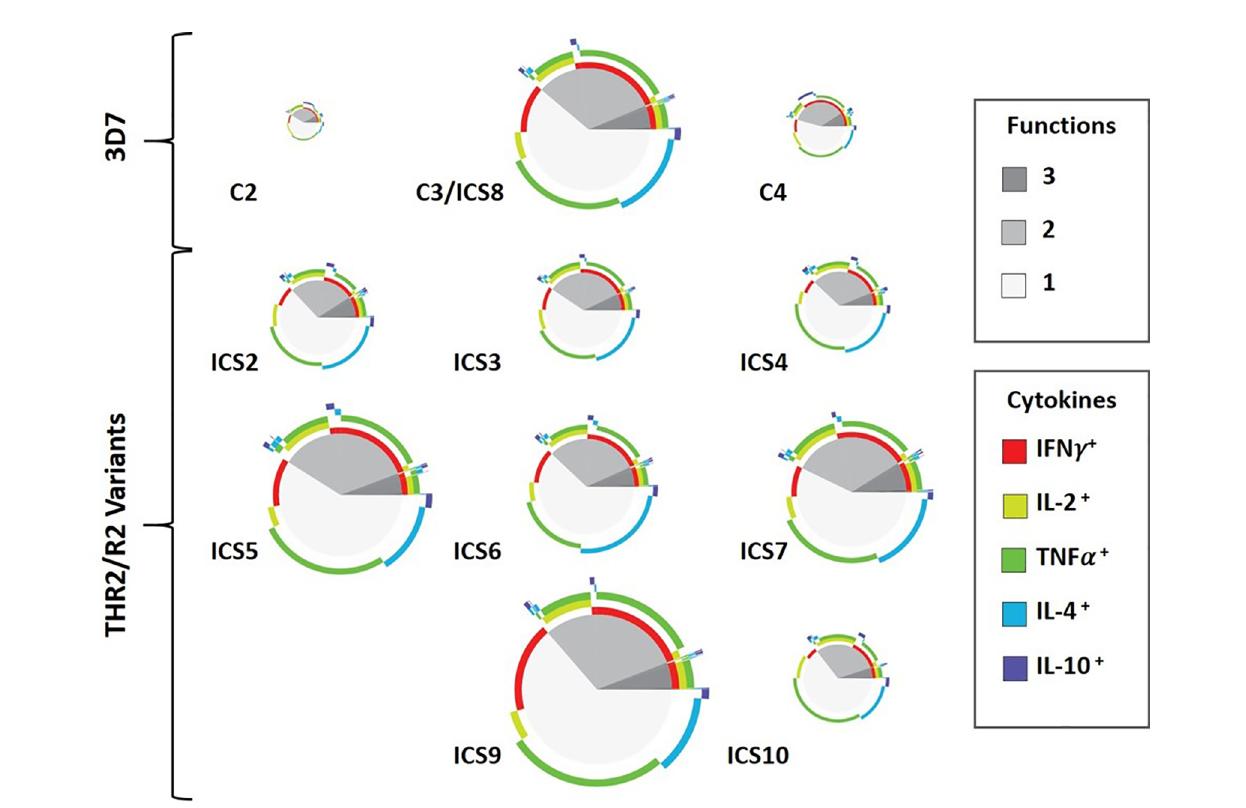
FIGURE 4 | Multifunctional Cytokine-Producing CD4 T Cell Response Pro fi les to Peptides Comprised of PfCSP-Predicted Epitope Clusters. Circular pie charts represent median response across all 30 donors (i.e., individual pie charts represent the median value of the summation of total magnitude for the combined cytokine responses from all the donors for each peptide). The proportion of single-, double-, and triple-function T cells is shown in grey tones (pie slices). The colored arcs highlight the total proportions of T cells secreting a particular cytokine or combination of cytokines. Relative magnitude of the overall median response (for all 30 donors to a peptide) can be gauged by size of the pie chart, with greater magnitude response represented by larger pie